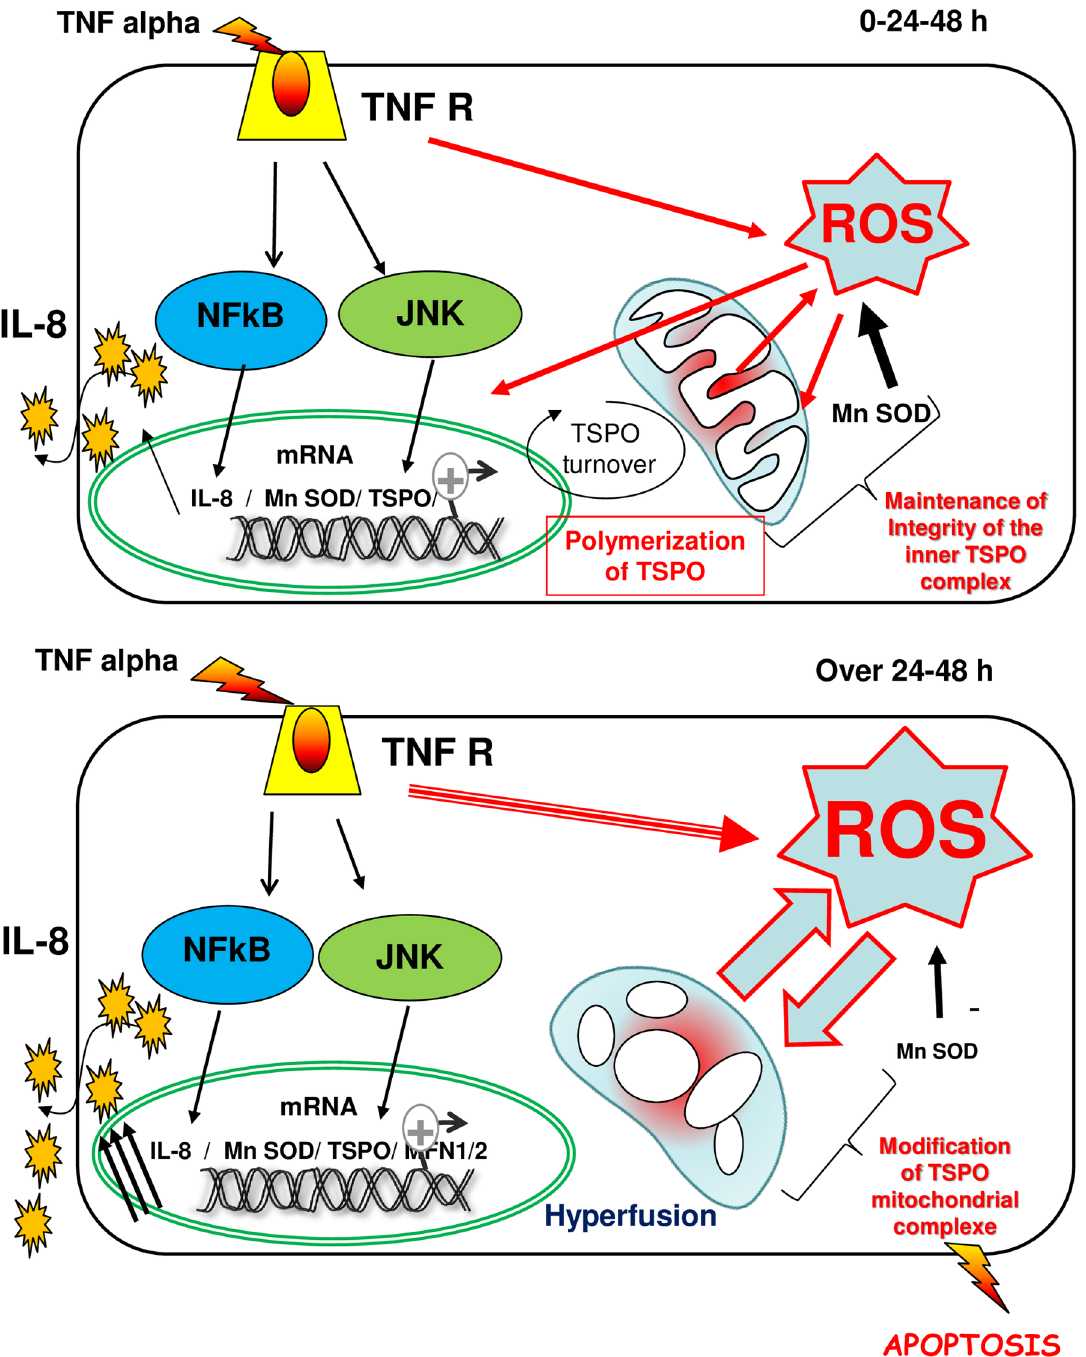
Fig 9. Modeling the involvement of TSPO upon TNF-induced inflammation. In the upper diagram, before 24 hours of treatment, TNF activates the production of IL-8 through NF κ B signaling, as previously described [63]. Under this condition, ROS are produced and the antioxidant defenses (MnSOD) are activated simultaneously to TSPO transcription by the JNK pathway [52]. ROS induce the formation of TSPO polymers acting as ROS scavengers, and they induce an increase in TSPO turnover. This mechanism maintains the integrity of the mitochondria (inner ultrastructure membrane complexes) and favors regulation of the ROS production. In the lower diagram, after 24 hours, treatment with TNF causes an overflow of antioxidant defenses together with sustained TSPO turnover, leading to the dysfunction of mitochondrial membrane complexes responsible of the disruption of inner mitochondrial integrity; the apoptotic cascade is then activated, leading to cell